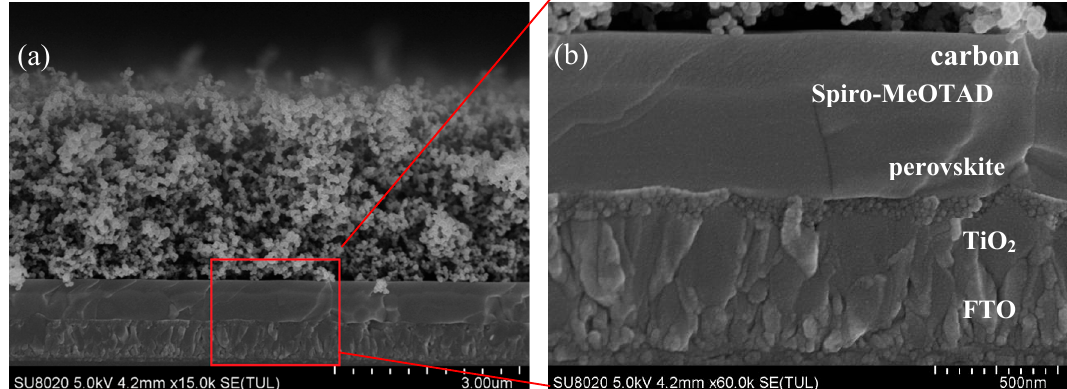
Figure 6. ( a ) Cross-sectional SEM images of perovskite solar cell with two cycles of spin-coating TiO 2 ; ( b ) An enlargement of the red frame in ( a ).